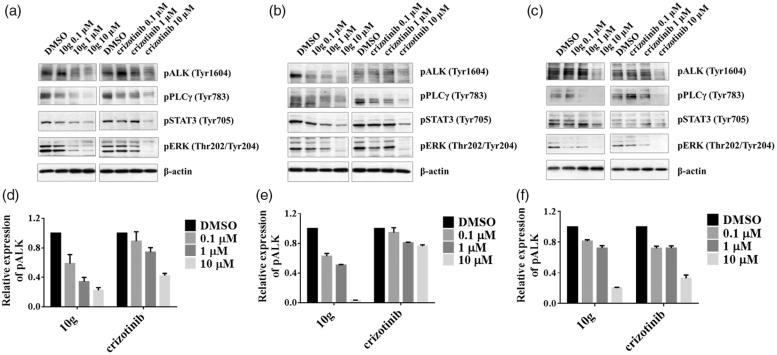
Autophosphorylation of ALK and its downstream signalling are inhibited by 10g. (a) effects of 10g in ALK wt-TEL Ba/F3 (b) ALK L1196M-TEL Ba/F3 (c) H2228 cell line. Ba/F3 cells transformed with ALK wt-TEL, ALK L1196M-TEL and H2228 cells were treated for 2 h with increasing concentration of 10g.